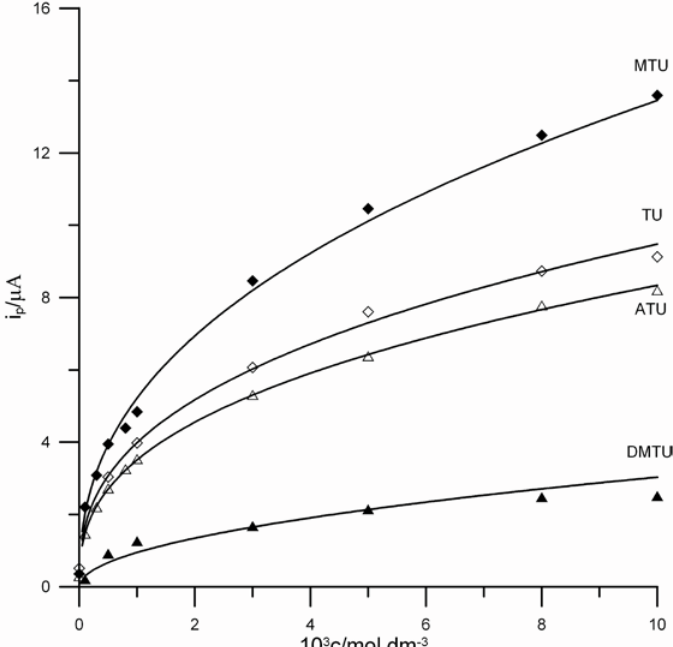
Figure 4. The dependence of 1×10 -3 mol dm -3 In(III) in 1 mol dm -3 NaClO ( D ) and DMTU [ 46] ( ▲ ) (mol dm -3